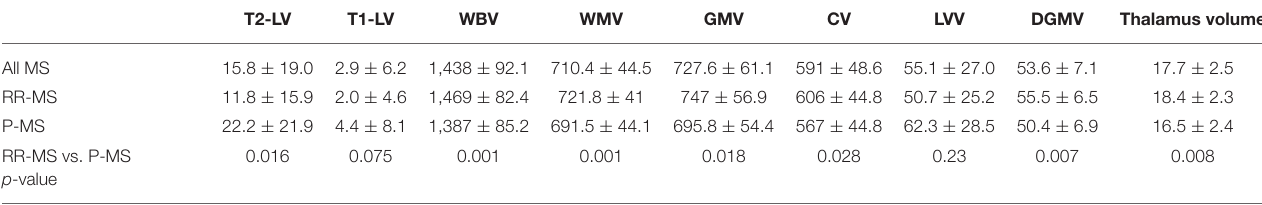
TABLE 2 | MRI characteristics of the study